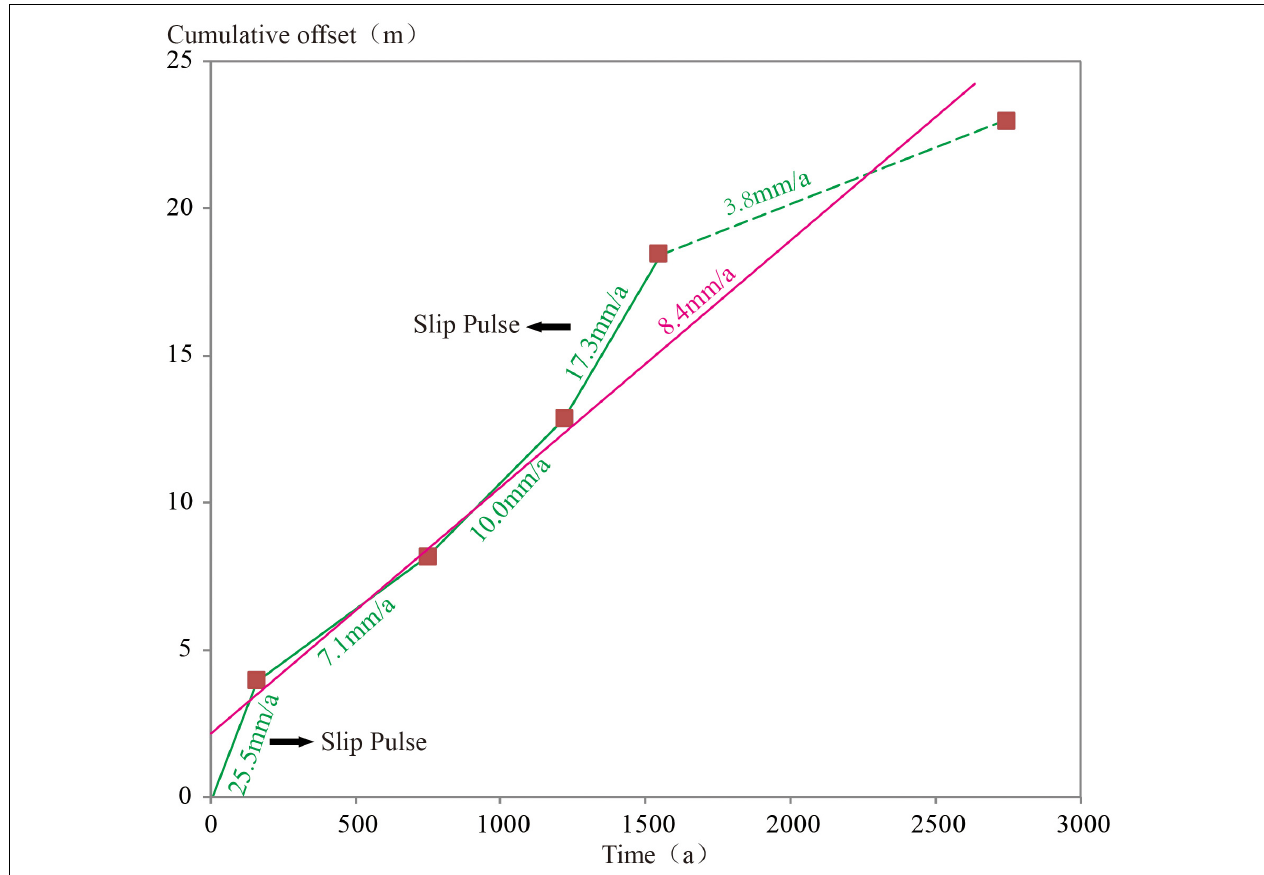
FIGURE 14 | Slip rates of the Luhuo segment over the past 3000 years. Green lines show slip rates in different periods. Purple line shows the average slip rate over past 3000